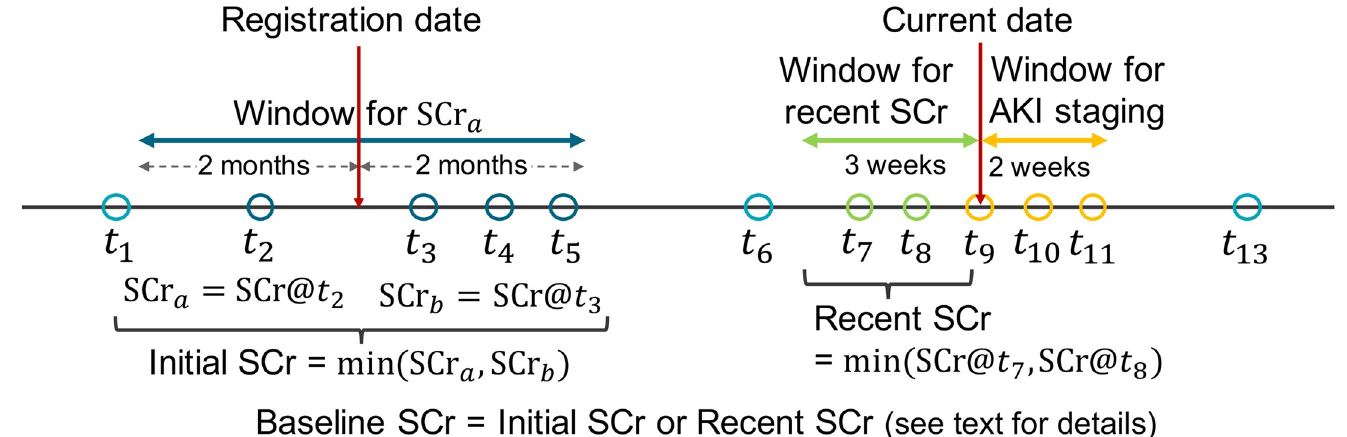
Fig 1. Definitions and time windows for serum creatinine (SCr) measurements used for detecting and staging AKI. Circles represent SCr measurements of a single patient taken at time points t 1 , (cid:1)(cid:1)(cid:1) , t 13 . Double-headed arrows represent time windows. The first window is centered around the registration date of a patient, and used to obtain SCr . The second and third windows are positioned next to each other such that the current date is located between them, and they are used for a obtaining recent SCr, and staging AKI, respectively. See text for more details on SCr a , SCr b , and baseline SCr.